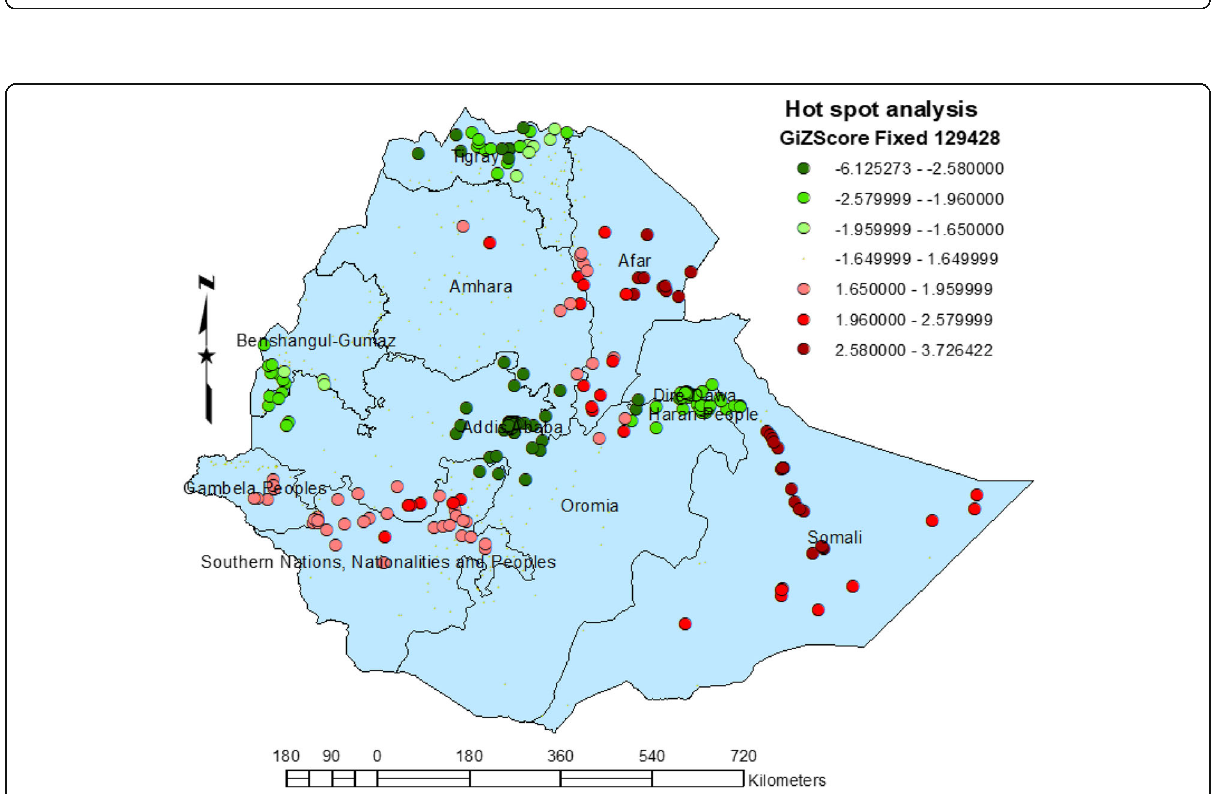
Fig. 3 Hot spots of defaulting immunization among children aged from 12 to 23 months in EDHS